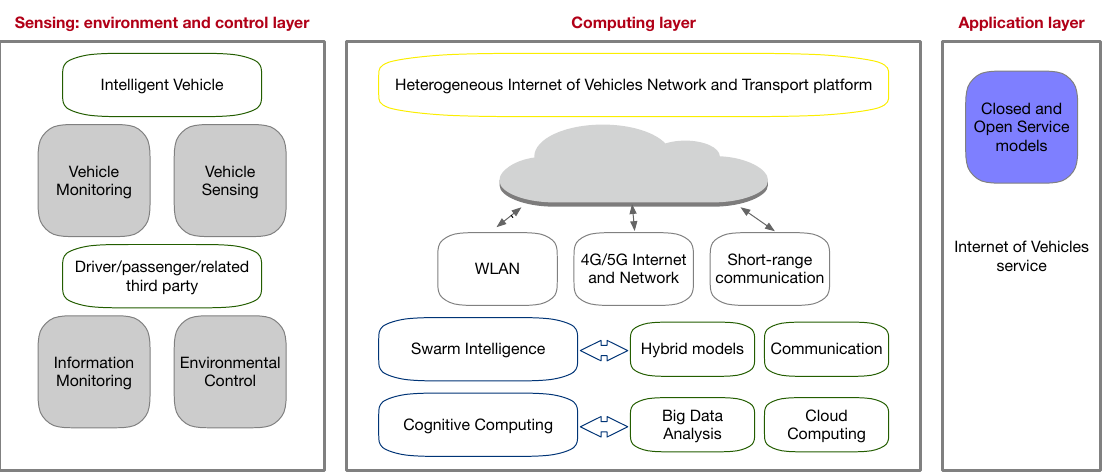
Figure 2. Basic components of Internet of Vehicles